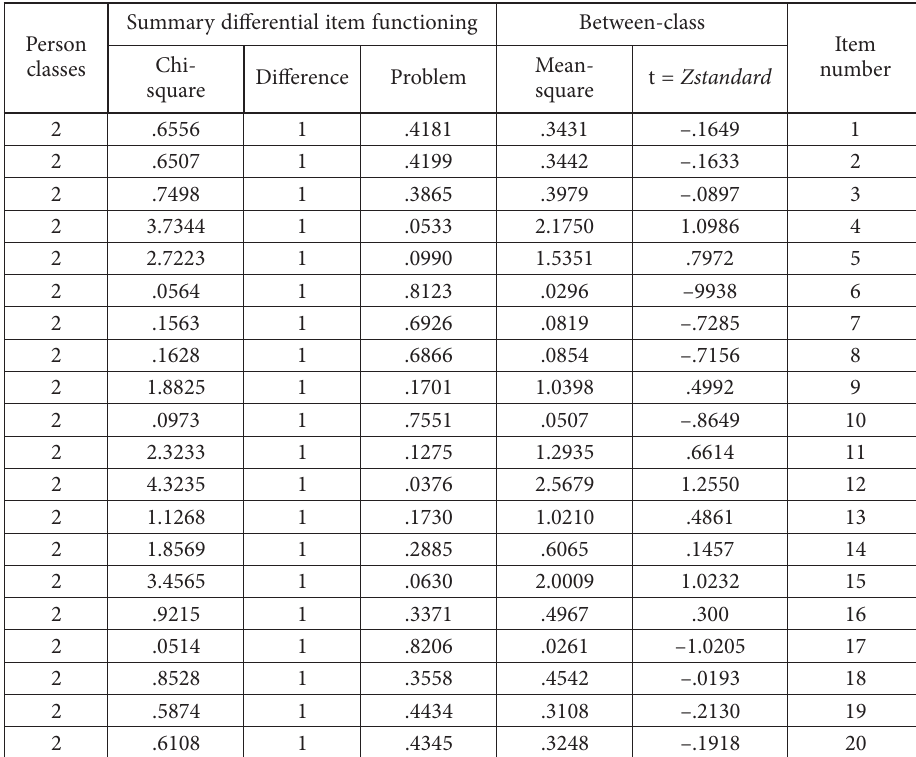
Table 6. Differential item functioning (source: created by authors) Summary differential item Person classes